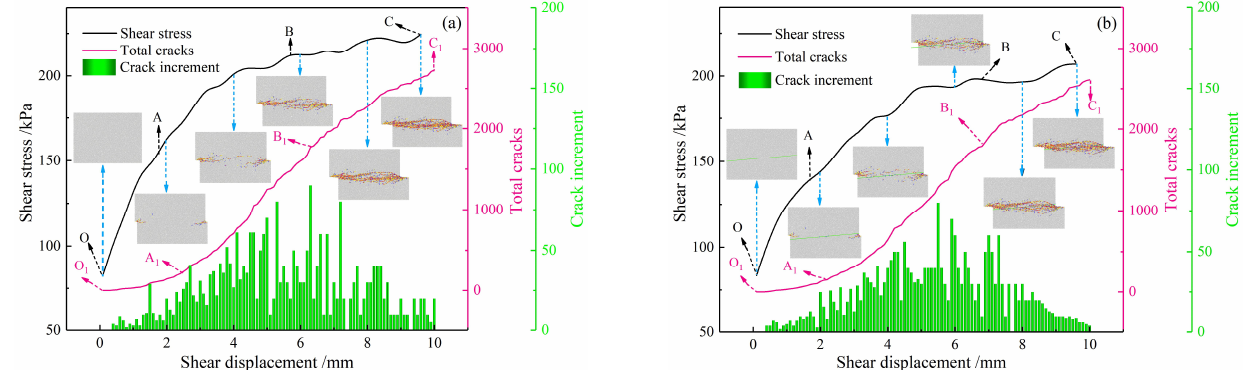
Figure 14. τ - δ , crack accumulation and crack increment curves: ( a ) N-L; ( b )